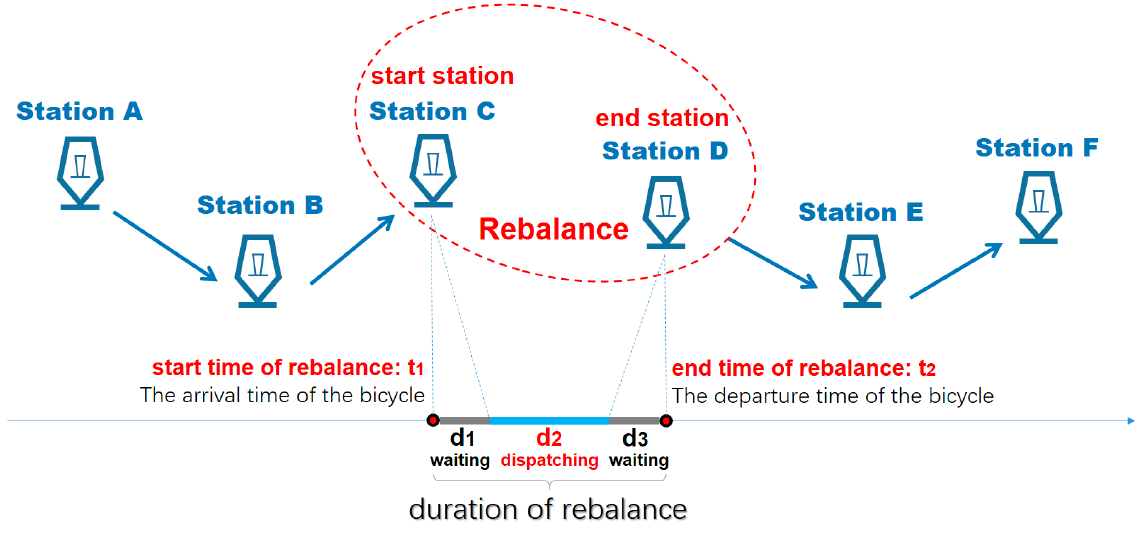
Figure 7. Detection of rebalance